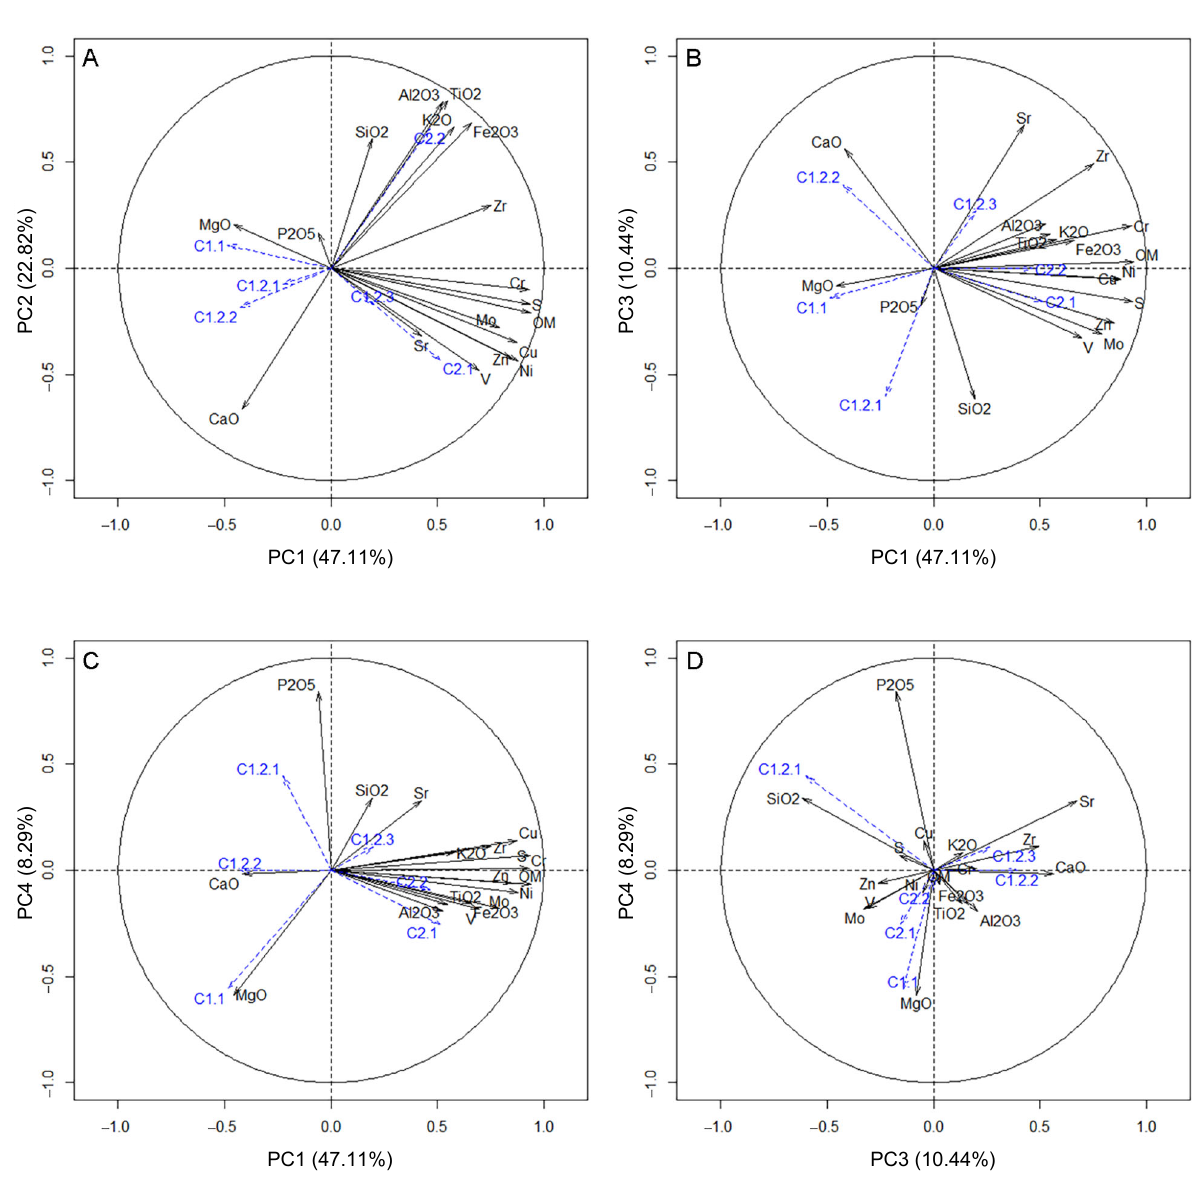
Fig. 4. Graphs of the analysed major and trace elements on the planes constructed by principal components. The distance between the chemical component projected onto a plane and the correlation circle with radius 1 demonstrates the correlation of the variable and principal components (Table 2). The distance from an axis shows the quality of how well the element is projected onto a corresponding plane. The proximity of variables on the plane means also strong association between individual elements (for example OM and S on planes A, B and C; see also Fig. 2 LOI500°C vs S plot). Clusters (C1.1 to C2.2) are presented to demonstrate the association between chemical components and principal components (see text for the explanations). On a main plane (explains 69% of variability) constructed by principal components PC1 and PC2, OM (LOI500°C), S, Cr, Mo, Cu, Zn and V are positively correlated to PC1, while MgO and CaO are negatively correlated to PC1. It means that samples with a high concentration of MgO have a low content of OM (LOI500°C), S, Cr, Mo, Cu, Zn and V, and vice versa. Strong positive correlation is between TiO 2 , Al 2 O 3 , Fe 2 O 3 , SiO 2 , K 2 O and PC2, while CaO is negatively correlated to PC2. Thus the samples with a high CaO content have low TiO 2 , Al 2 O 3 , Fe 2 O 3 , SiO 2 and K 2 O contents, and vice